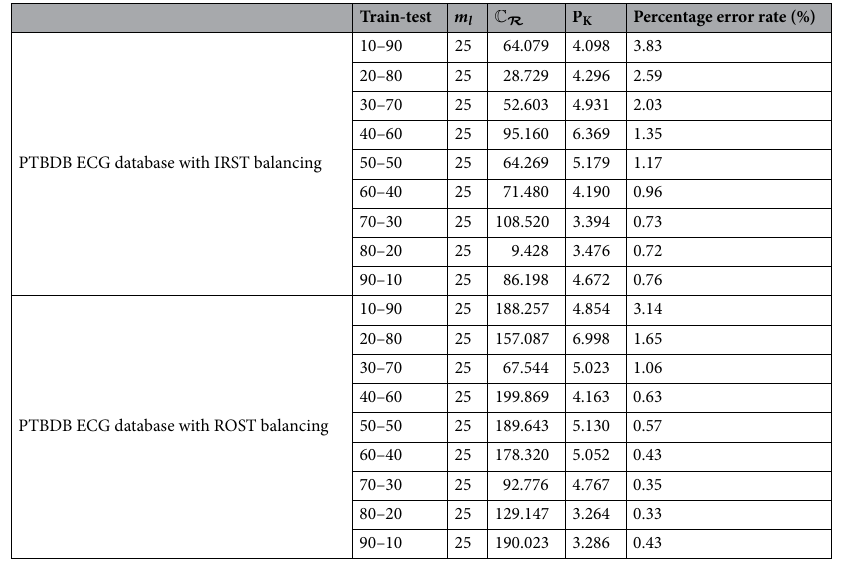
Table 9. Percentage error rate with values of m l , C R and P K obtained using proposed approach on PTBDB ECG